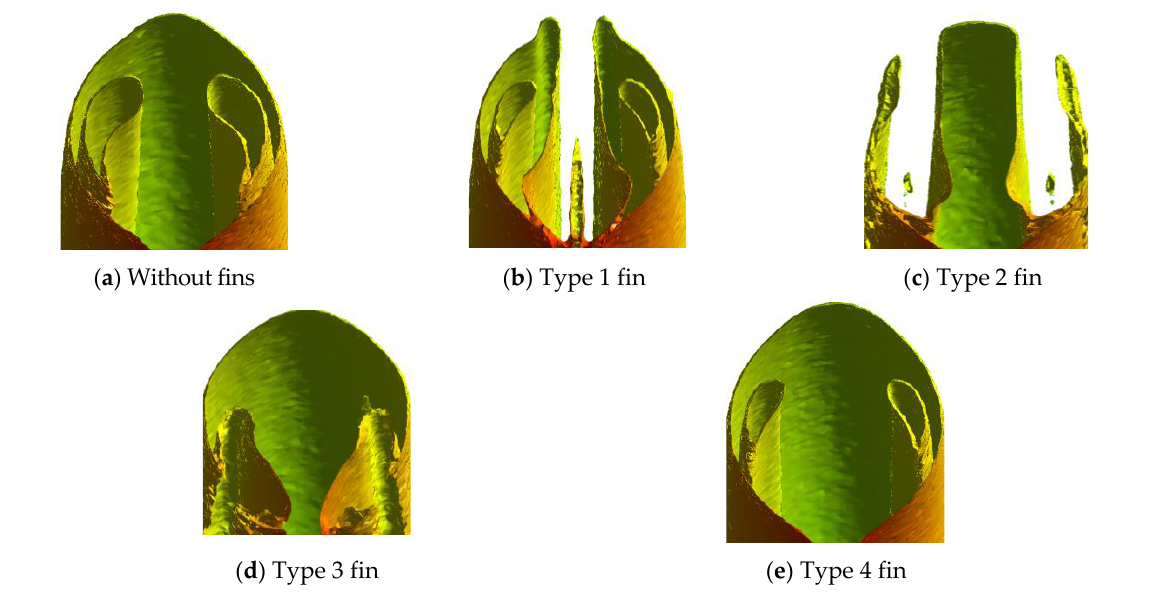
Figure 9. Vortex formation in section 5 of an inlet pipe.